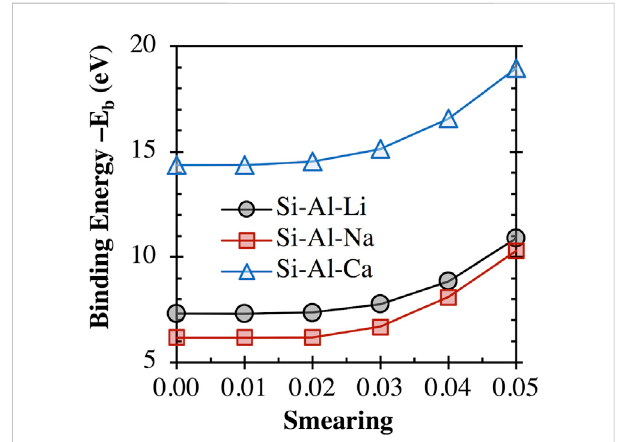
FIGURE 1 Impact of thermal smearing value on the binding energy between an aluminosilicate dimer (i.e., [(OH) 3 -Si-O-Al-(OH) 3 ] − 1 ) and a Li + , Na + , or Ca 2+ cation, calculated using Eq.